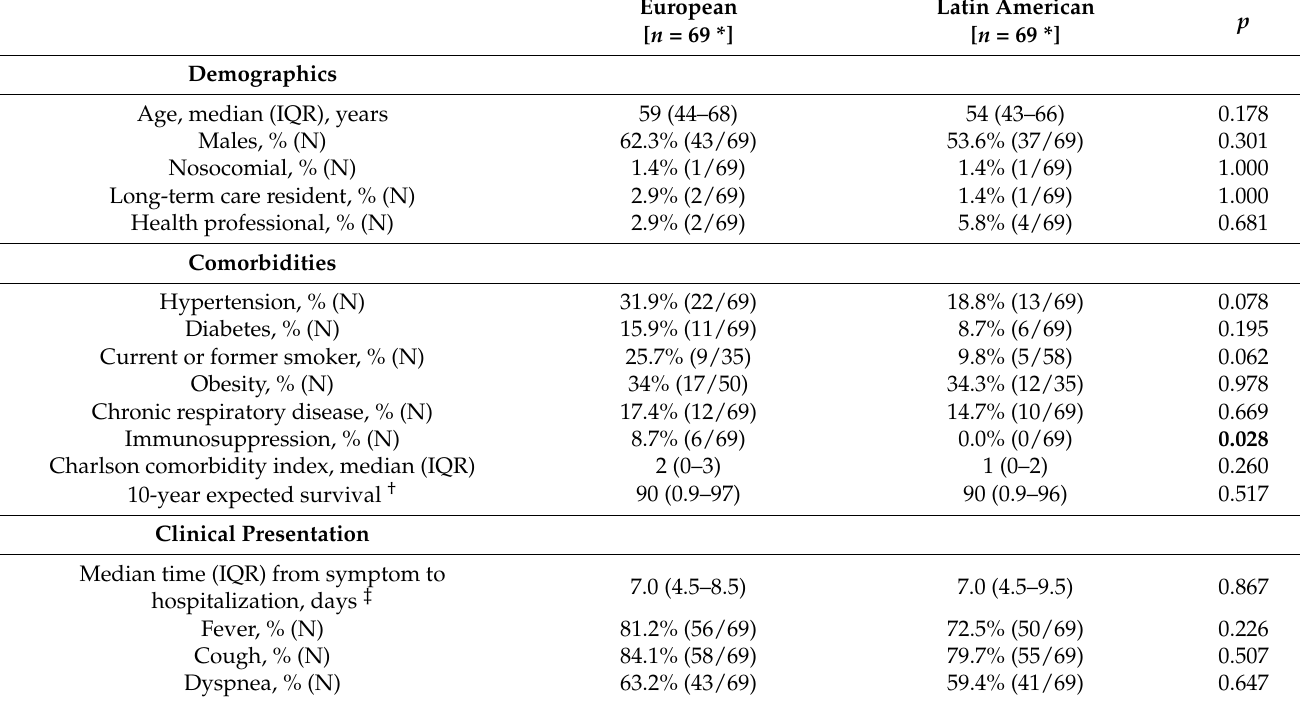
Table 2. Basal demographic characteristics, comorbidities, and clinical presentation by origin/race after matching.